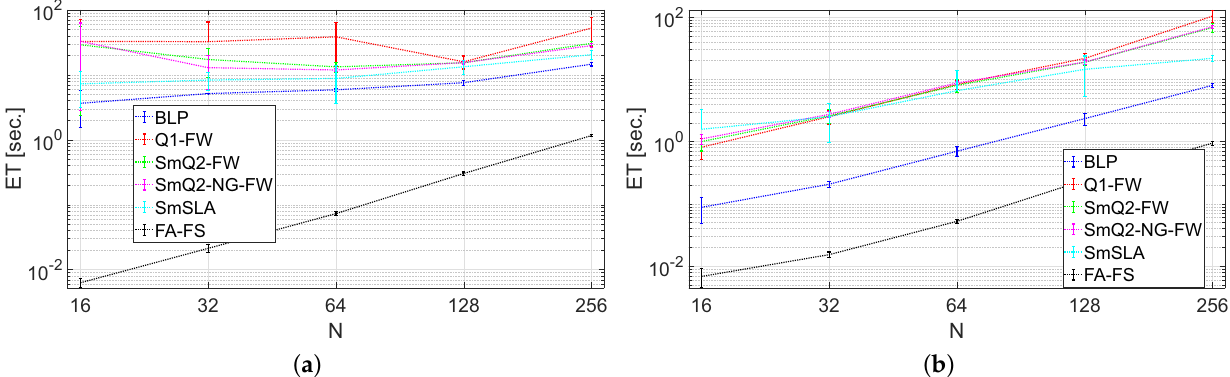
Figure 6. Averaged elapsed time (ET) for running the schedulers with ( a ) random charging rates and ( b ) a constant charging